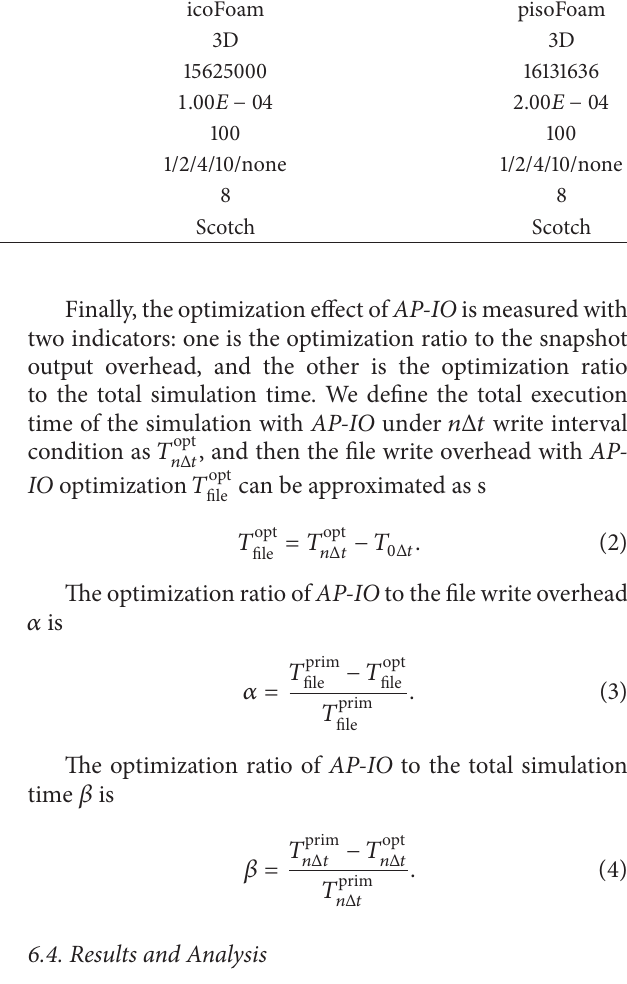
Table 1: The parameters of the three benchmark.